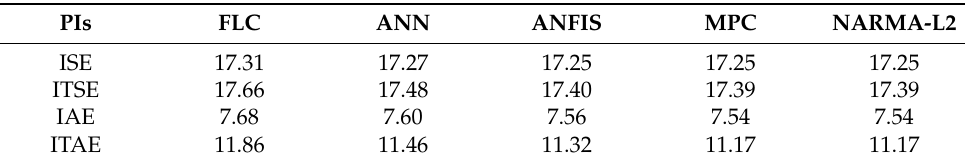
Table 7. Performance indexes for fixed reference (5